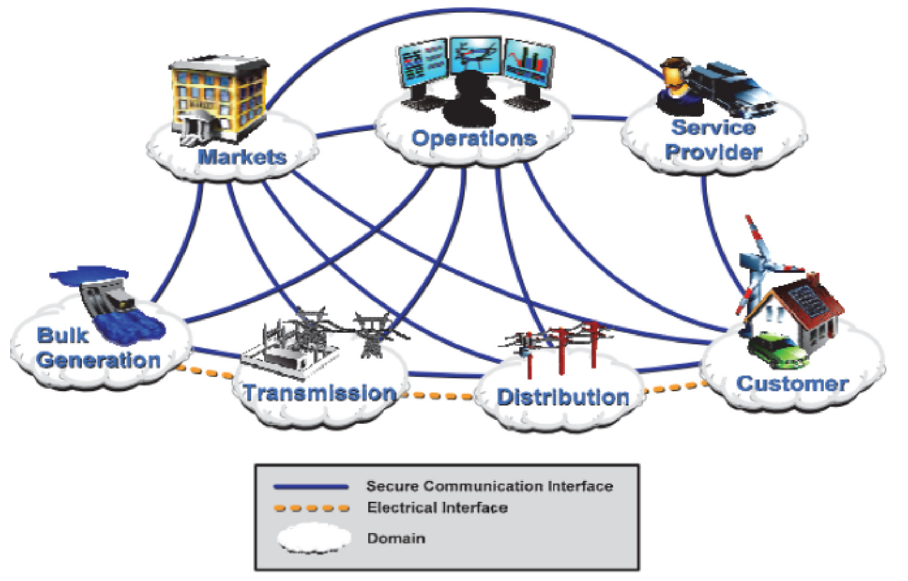
Figure 2. Conceptual scheme of Smart Grids according to NIST.